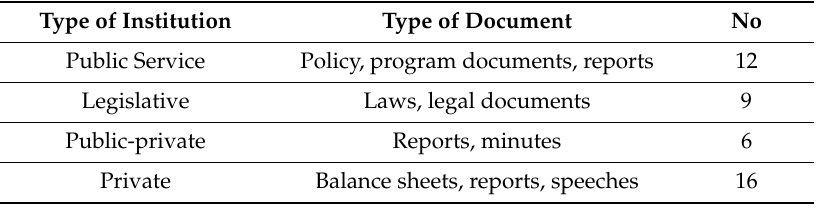
Table 1. Analyzed documents according to the type of